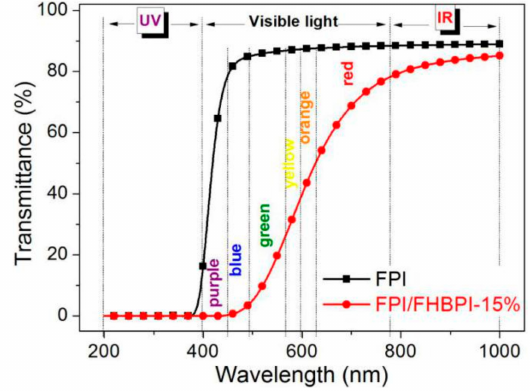
Figure 9. UV-vis light transmittance spectra of FPI and FPI / FHBPI-15% (about 0.05 mm